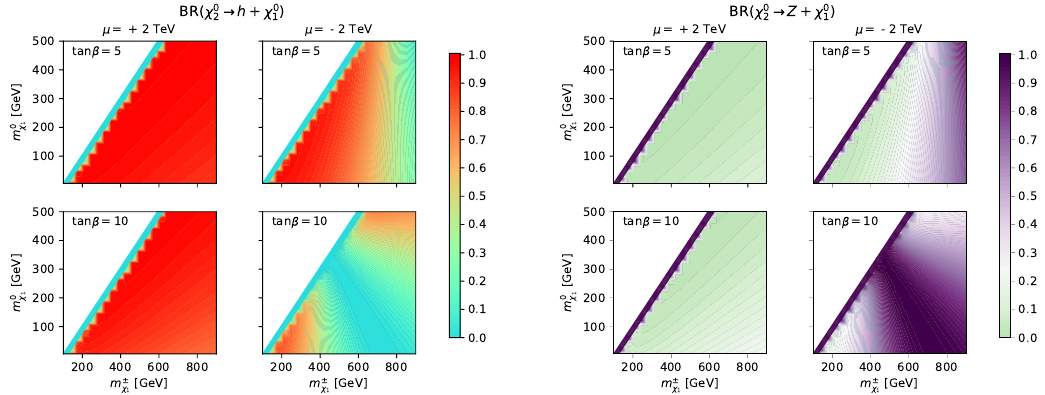
to the SM Higgs boson and χ 0 2 – m plane. Right: branching ratio of χ 0 χ 0 1 χ ± 1